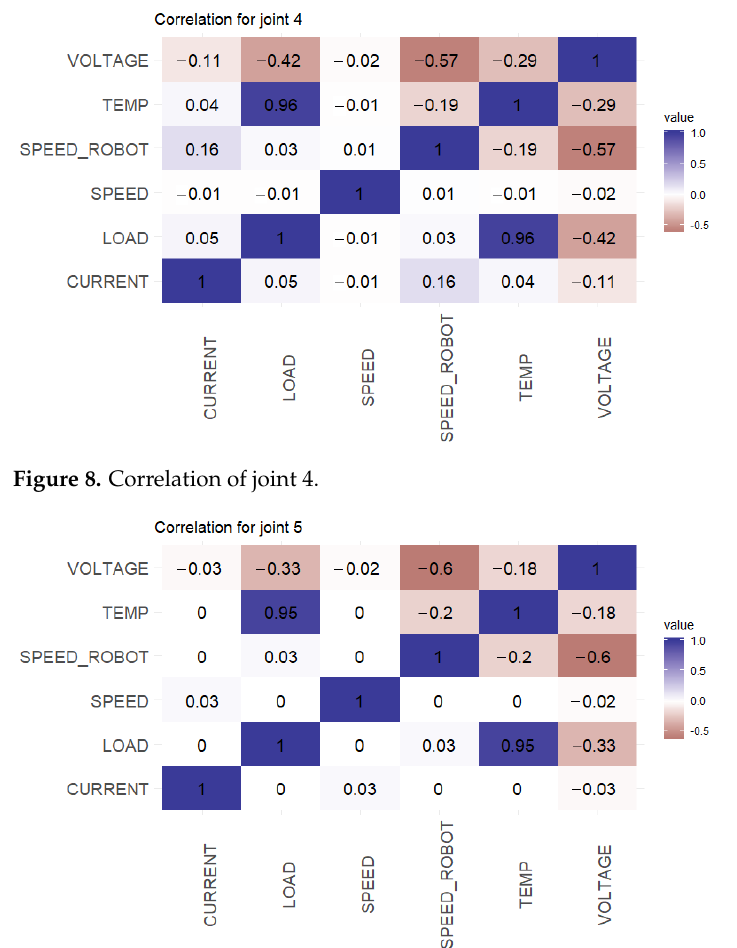
Figure 9. Correlation of joint